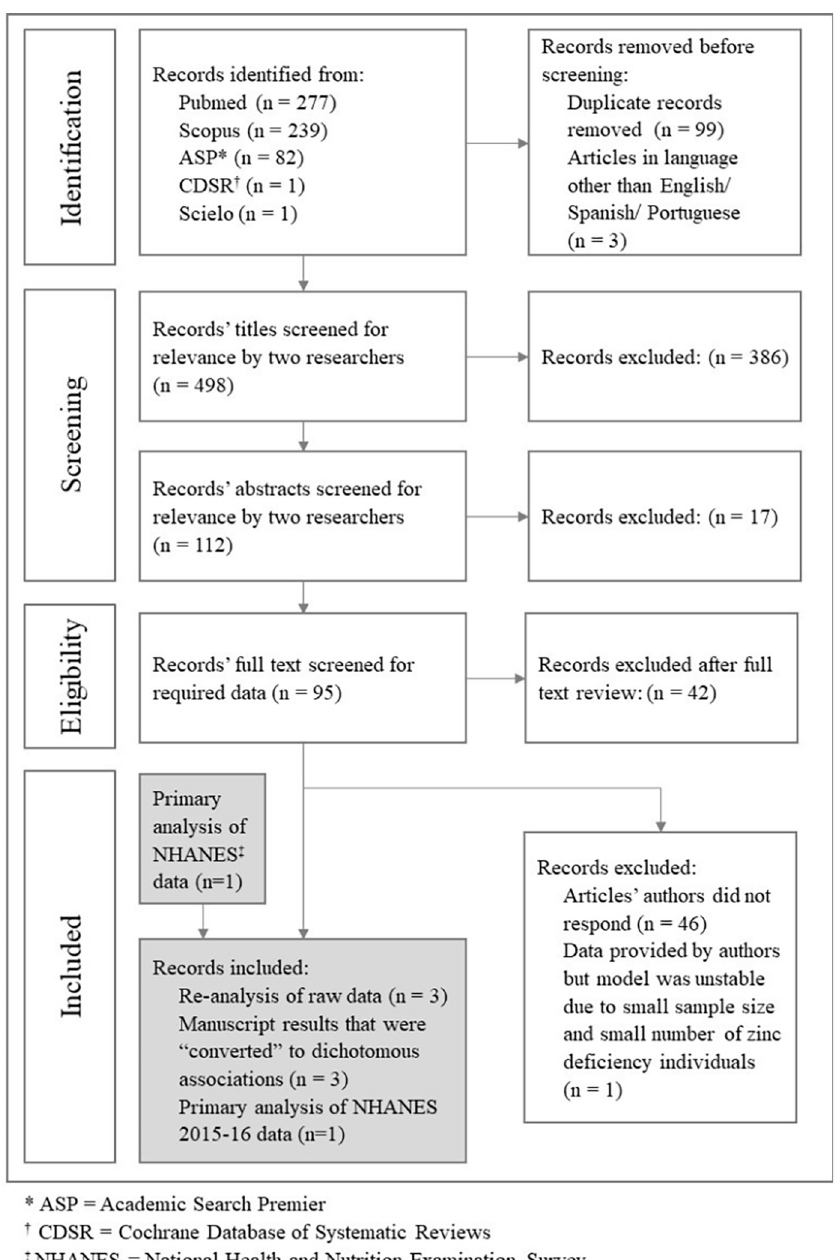
Fig 2. PRISMA flow chart for study